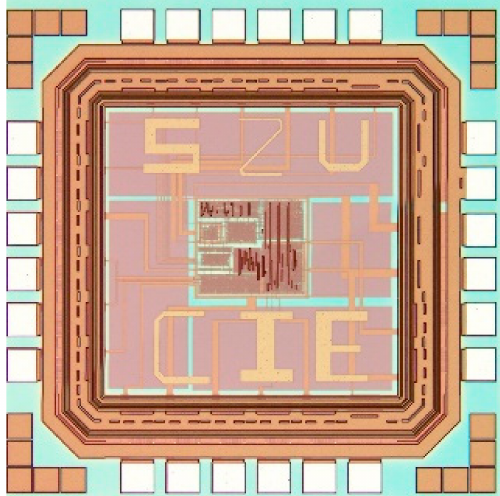
Figure 10. The microphotograph of the proposed NS-ADPLL.